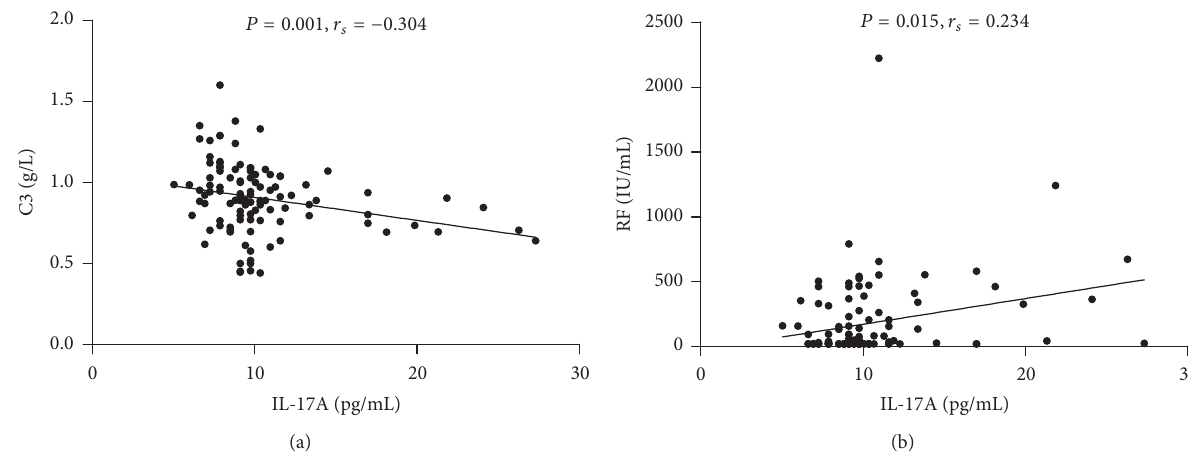
Figure 3: Correlation of serum level of IL-17A with laboratory parameters in pSS patients: (a) IL-17A were negatively associated with C3; (b) IL-17A were positively associated with RF.